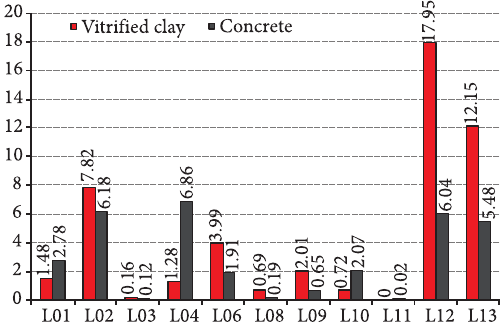
Fig. 11. Frequency of spot defects in vitrified clay and concrete sewers, in number per 100 m